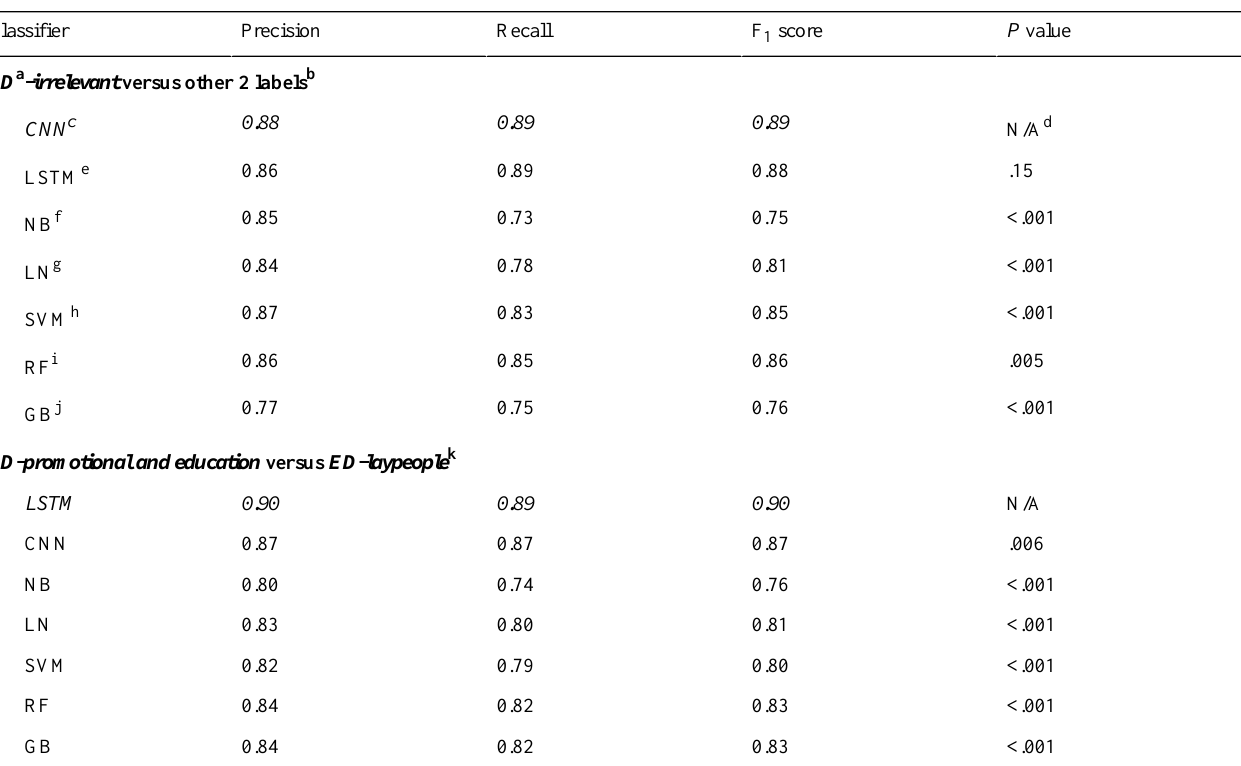
Table 1. Performances of the developed